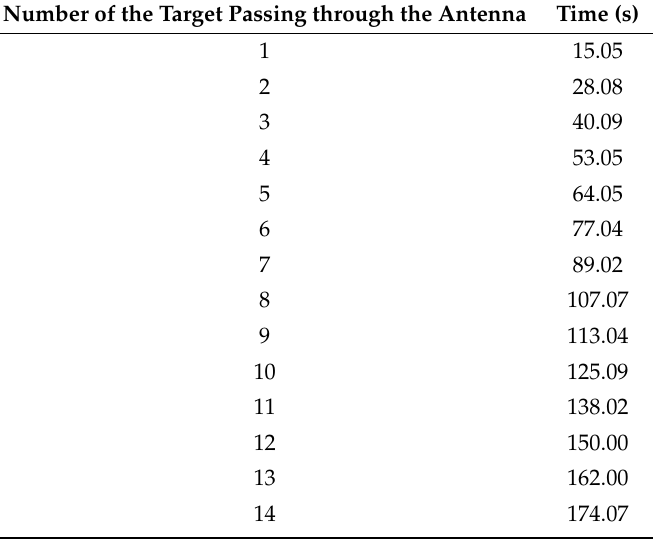
Table 2. Time information for the target passing through the